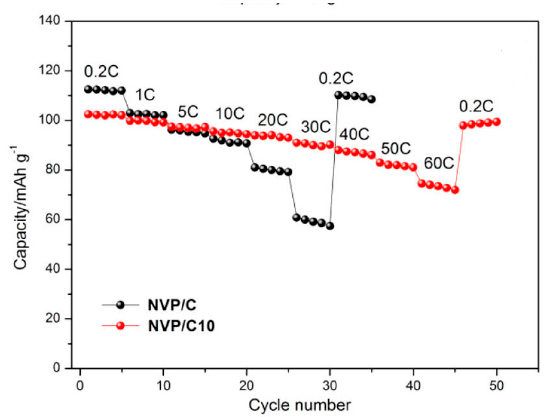
Figure 14. Overview of a structural characterization study conducted on spray-dried Si/C composites at different stages during individual cycles. The set of characterizations was repeated every 20 cycles. (Reproduced from reference [79] under CC BY 4.0—https://creativecommons.org/licenses/by/4.0/).